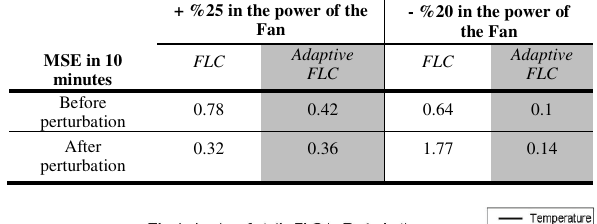
Table 6. Comparative performance indices before and after the perturbation.